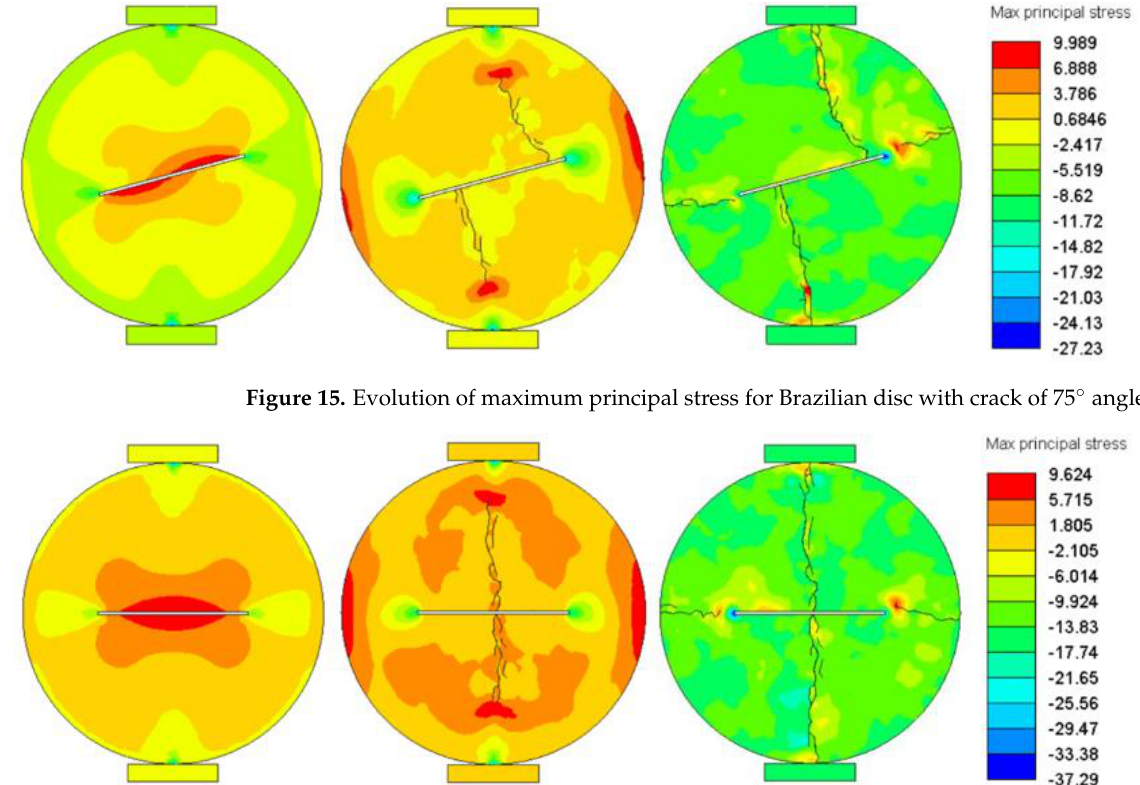
Figure 14. Evolution of maximum principal stress for Brazilian disc with crack of 60° angle.